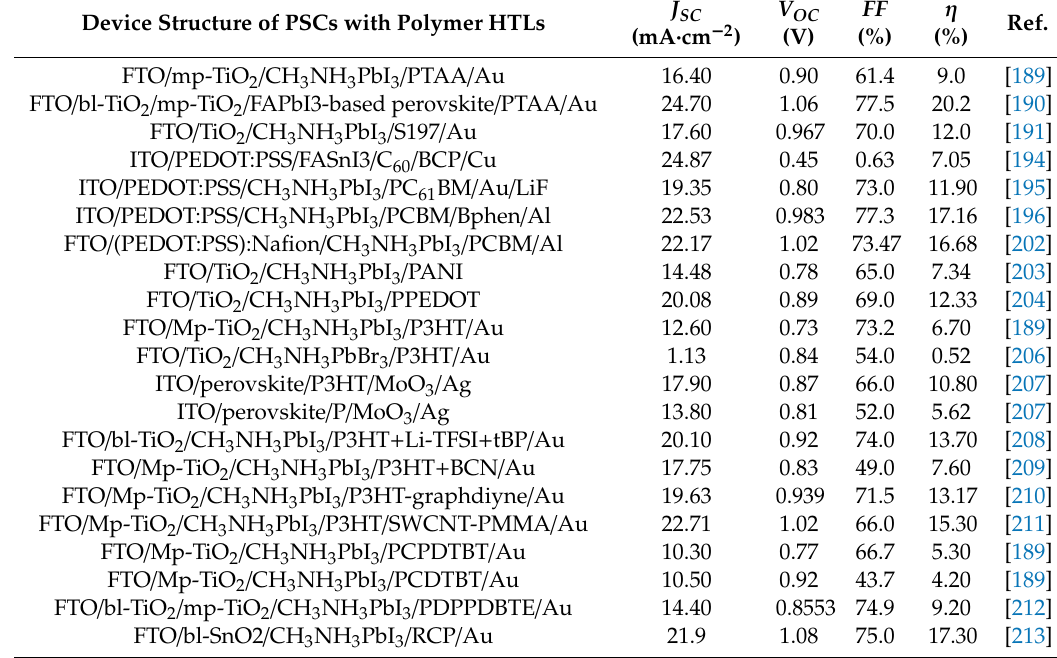
Table 6. Photovoltaic performances parameters of PSCs based on the di ff erent polymer HTLs. Device Structure of PSCs with Polymer